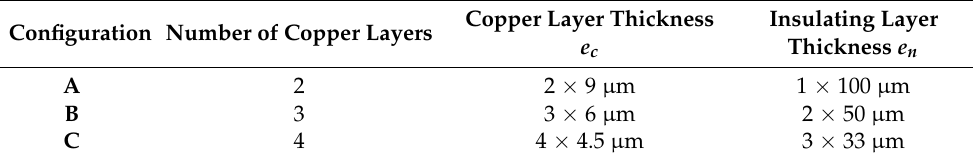
Table 1. Configurations of multilayer shielding screens with a same total thickness.